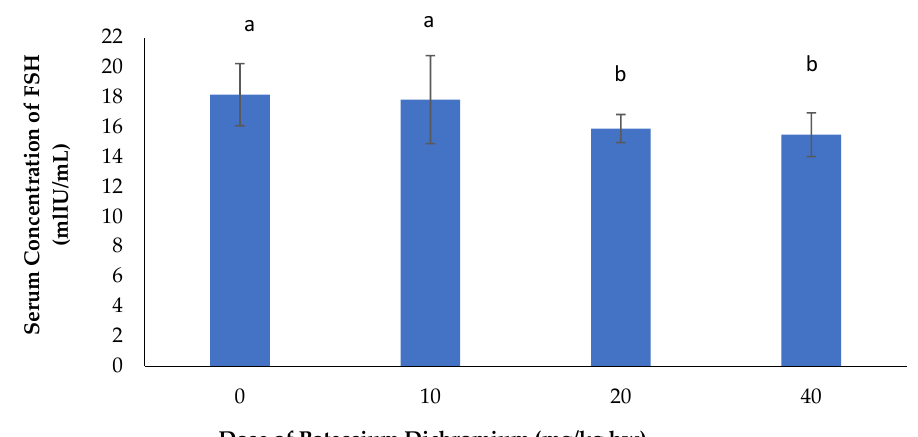
Figure 2. Effects of potassium dichromate on serum concentration of FSH in rabbit does. a,b: bars affected with the same letter do not differ significantly ( p > 0.05).